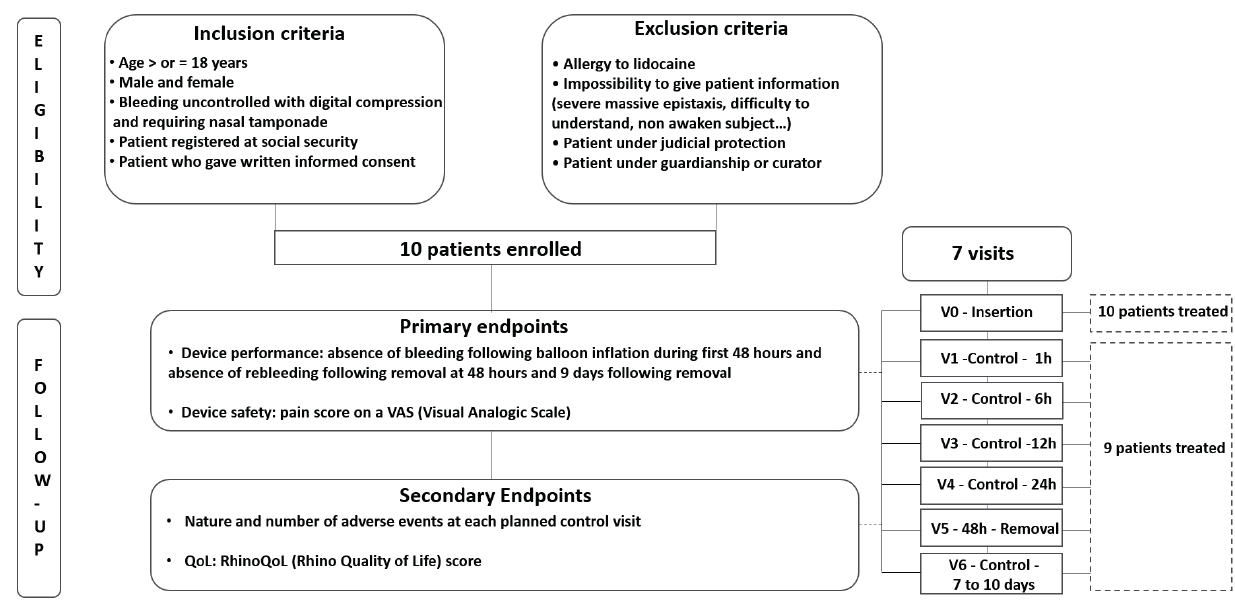
Figure 2. Description of the design of the